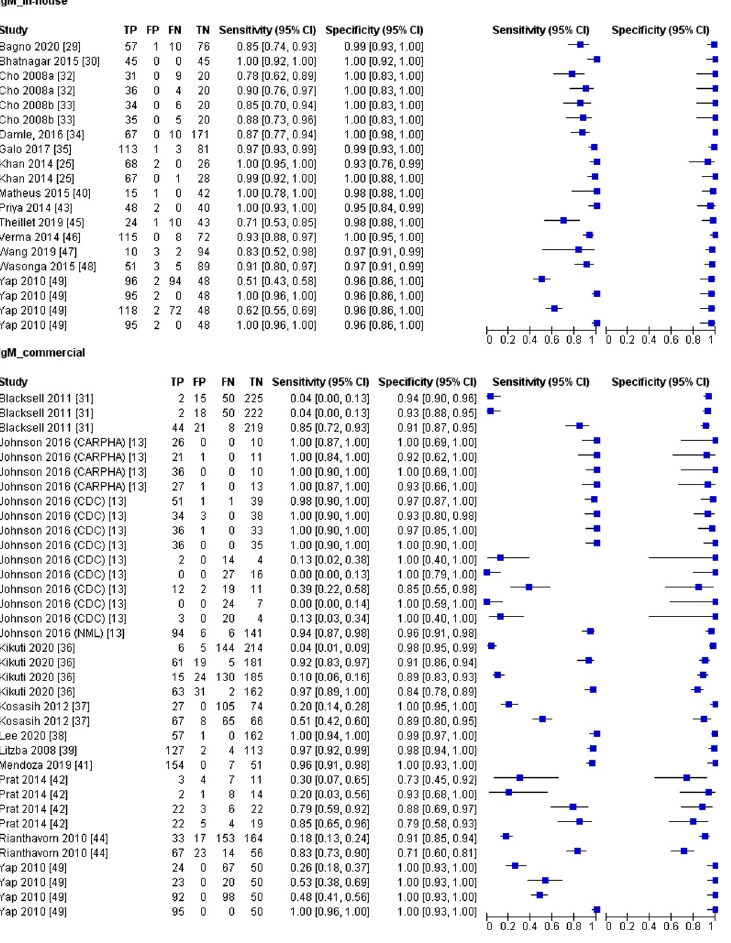
Fig 4. Forest plot for IgM detection test based on in-house developed and commercial test; CI, confidence interval; TP, true positive; FP, false positive; FN, false negative; TN, true negative.